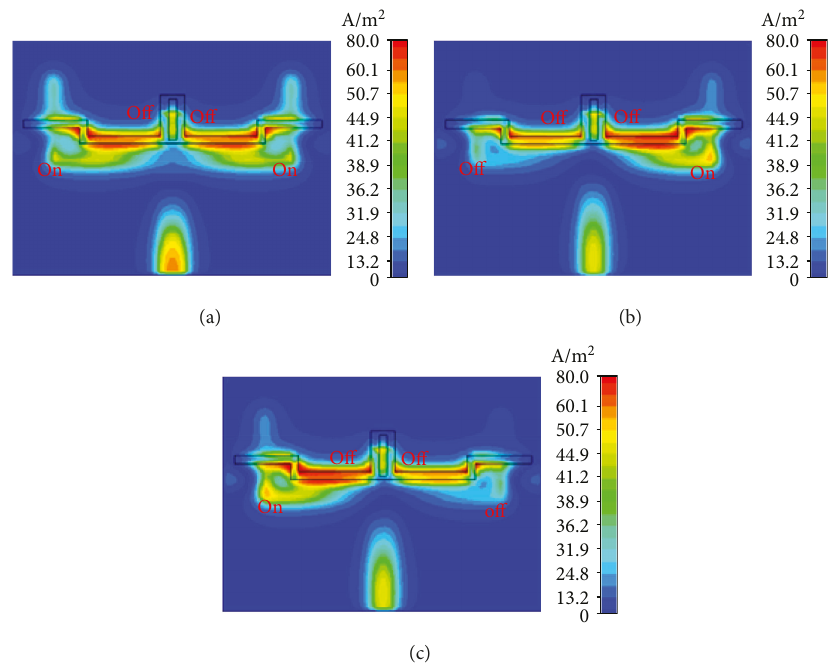
Figure 4: Surface current distributions. (a) Mode 1. (b) Mode 2. (c) Mode 3.